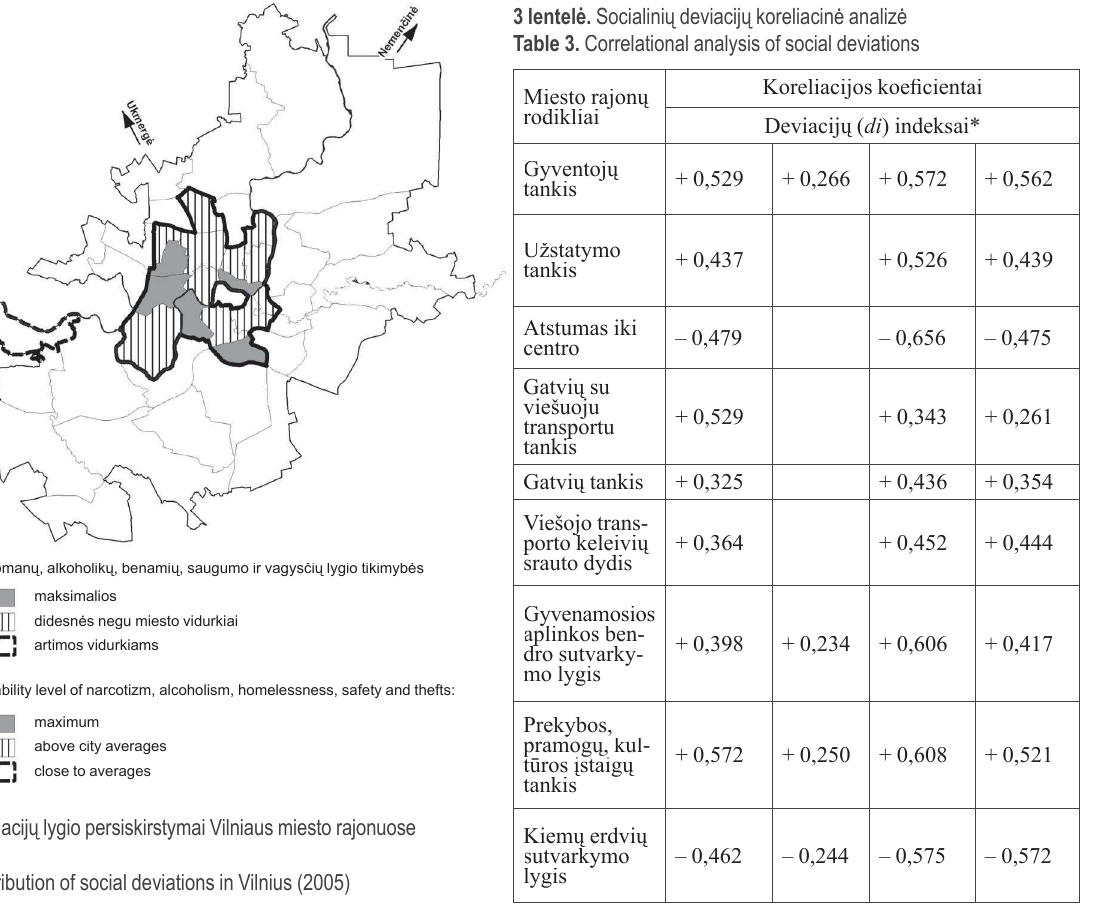
Fig 1. Distribution of social deviations in Vilnius